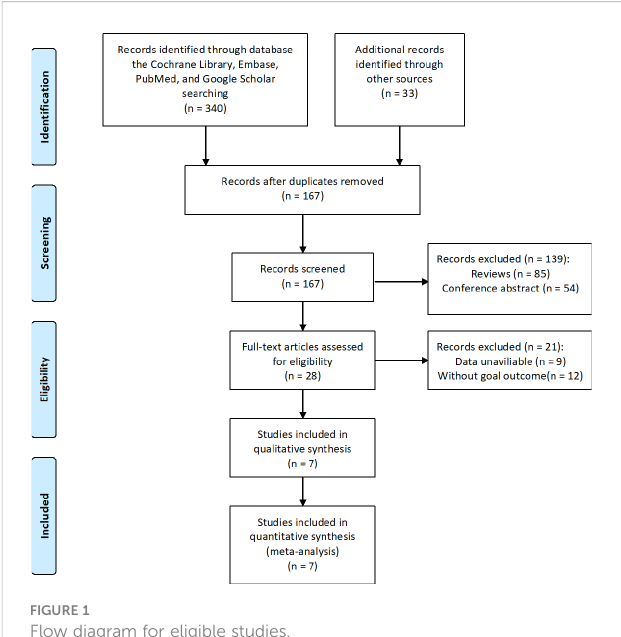
FIGURE 1 Flow diagram for eligible studies.